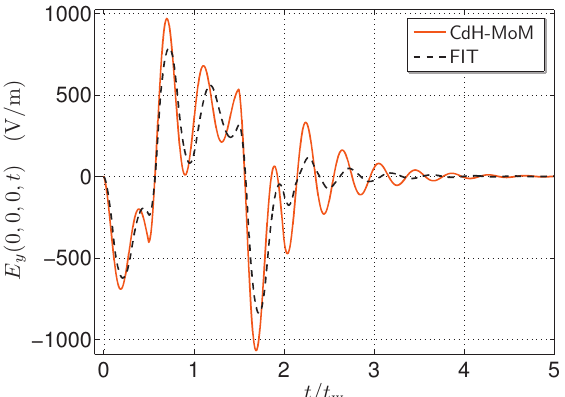
Figure 4. Pulse shape of E y -field as induced at the center of the narrow aperture with relative dimensions 2 ∆ x / c 0 t w = 1/5 and 2 ∆ y / c 0 t w =